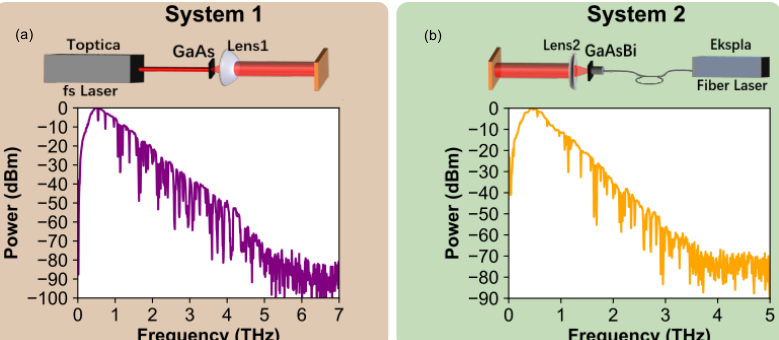
Figure 2. Schematics of THz TDS investigation set-ups and their emission spectra. System 1 (panel ( a )) is based on femtosecond fiber laser (Femtofiber Pro, Femtofiber Pro, Toptica Photonics Ag, Munich, Germany) delivering pulses of 780 nm wavelength and 90 fs pulse duration pulses to excite THz emission from photoconductive antenna made from LT-GaAs. System 2 (panel ( b )) consists of femtosecond fiber laser (LightWare FF50, Ekspla, Vilnius, Lithuania) with a center wavelength of 1064 nm and 150 fs pulse duration pulses employed to excite THz radiation from GaAsBi-based emitter. Please note that both THz spectra are decorated by sharp lines of absorption in water